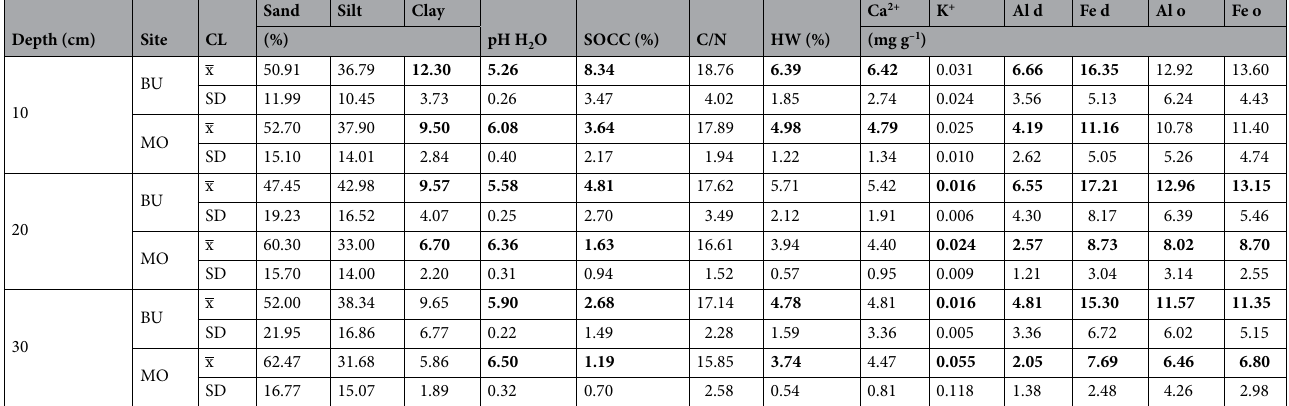
Table 1. Physical and chemical properties of soils in Bucharama (BU) and Malyj Orokan (MO). Each value was calculated from 15 samples. Values in bold indicate statistically significant differences (p < 0.05) between the two sites for a given property and the same depth. BU Bucharama, MO Malyj Orokan, CL central location, x average value, SD standard deviation, SOCC soil organic carbon concentration, HW hygroscopic